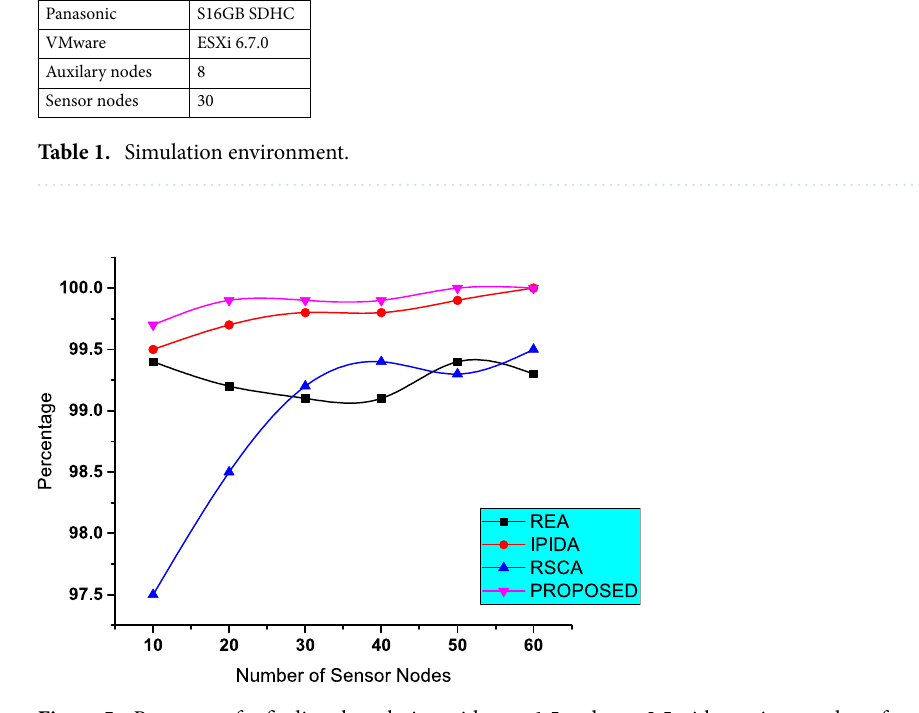
Figure 5. Percentage for finding the solution with α = 1.5 and γ = 2.5 with varying number of